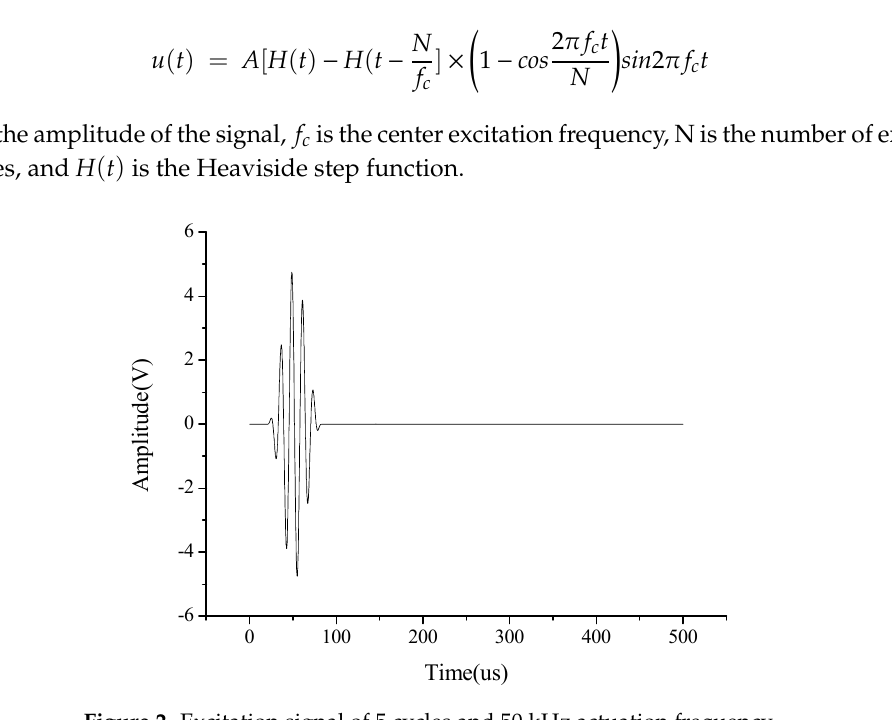
Figure 2. Excitation signal of 5 cycles and 50 kHz actuation frequency.